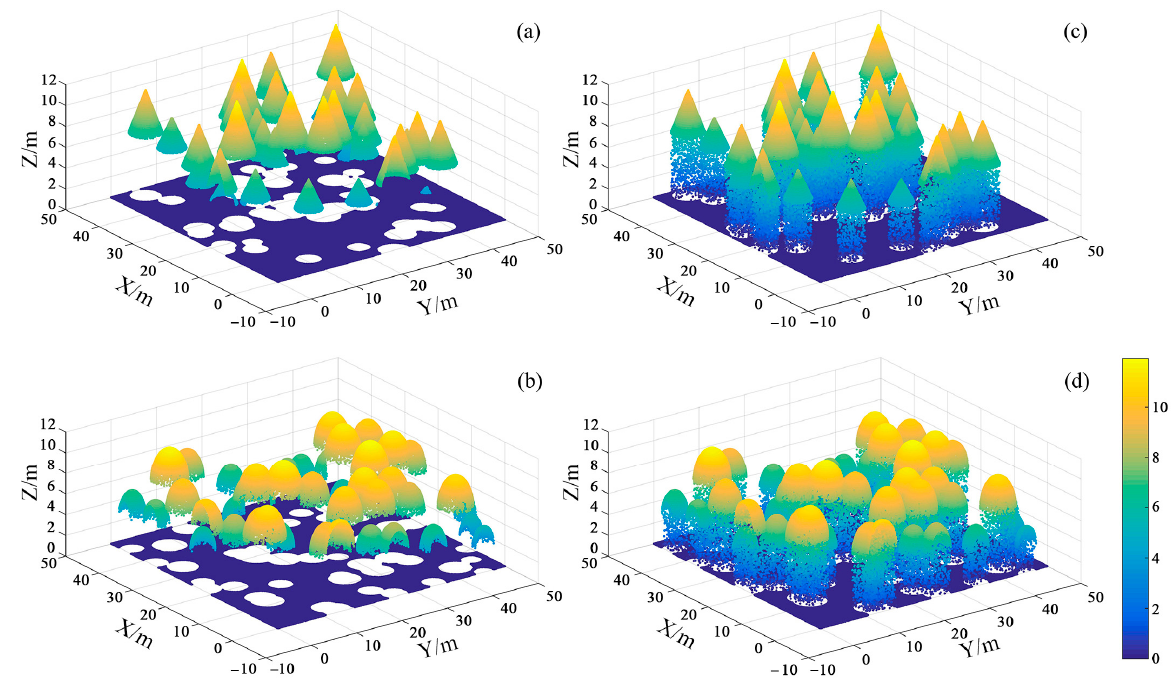
Figure 1. Simulated point clouds: ( a , b ) are the surface points and ( c , d ) are the simulated point clouds with 20% pits added to the cone and hemisphere, respectively.